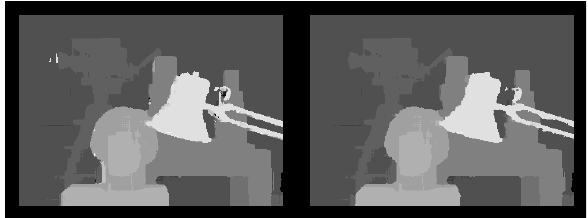
Figure 7. Disparity map of the left Tsukuba image before (left) and after (right) occlusions and mismatches have been handled.